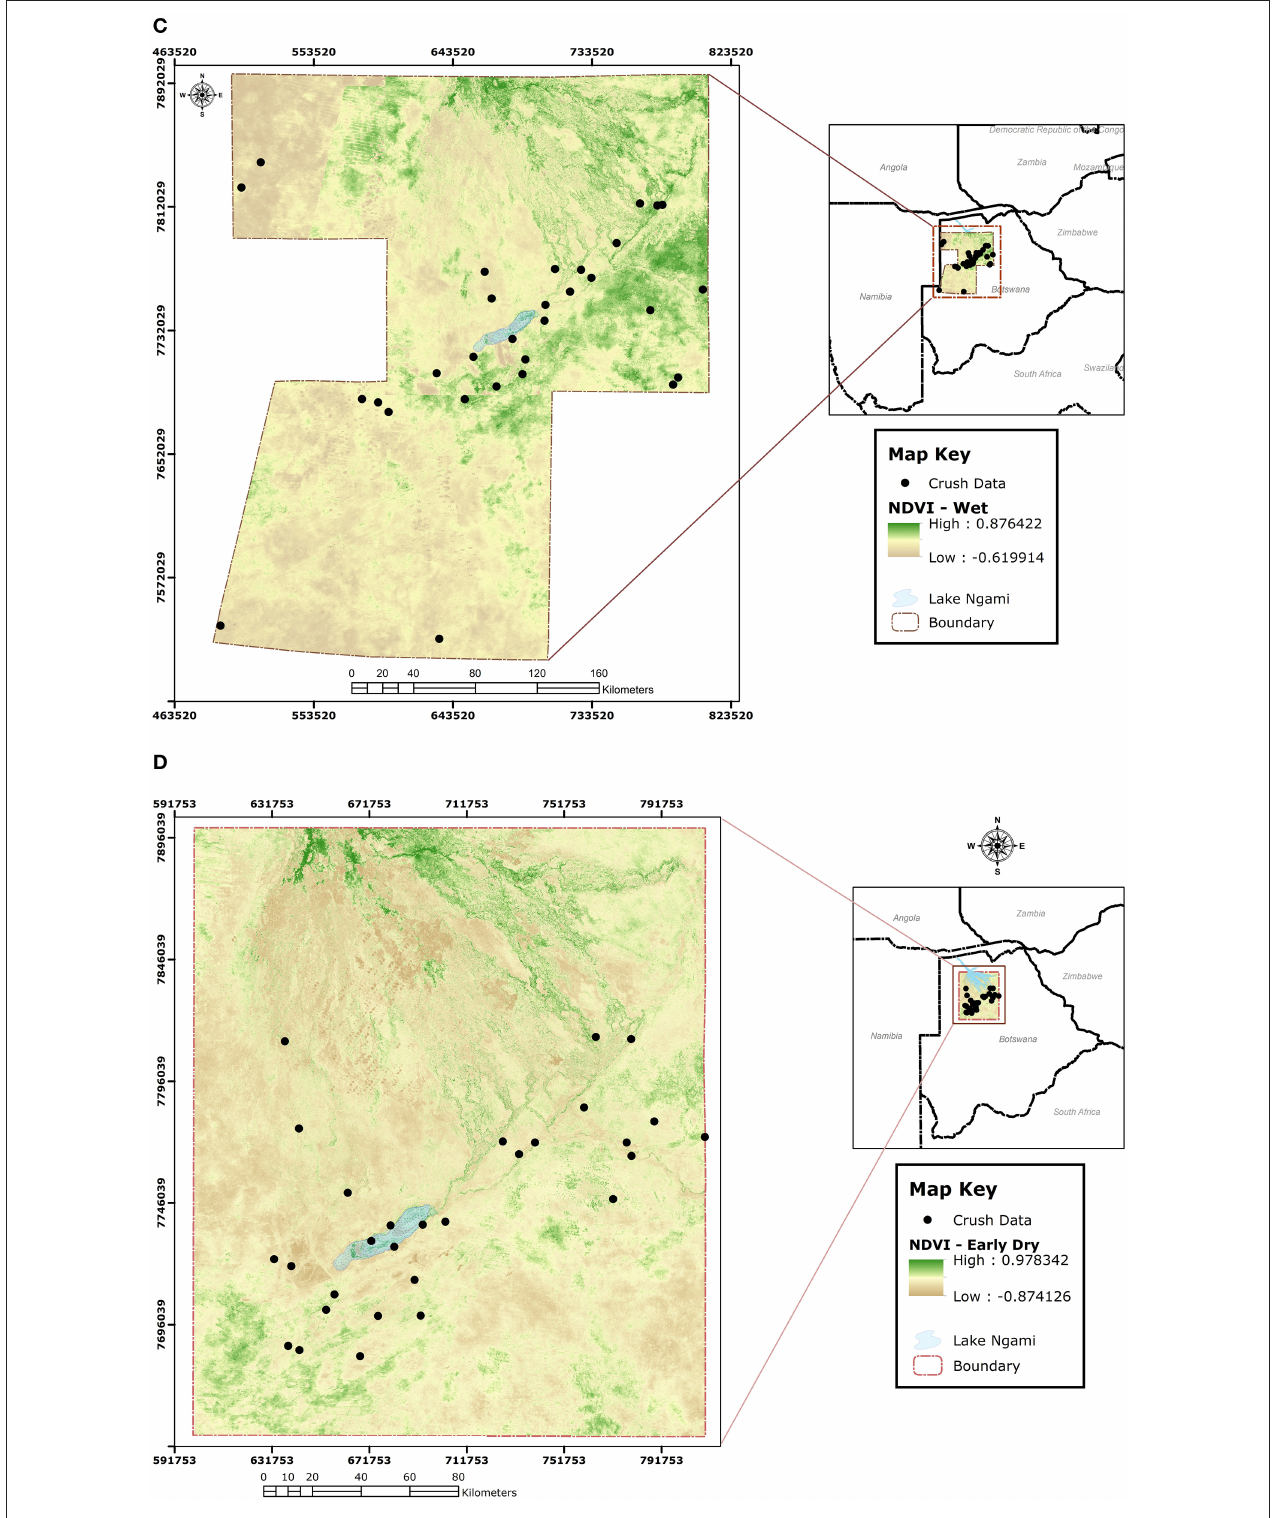
FIGURE 3 | Sentinel 2 satellite images obtained over the study area with superimposed point locations of crushes from which NDVI values were extracted during each of the four seasons, being cold-dry (A) , late-hot-dry (B) , wet (C) , and early-dry (D) .